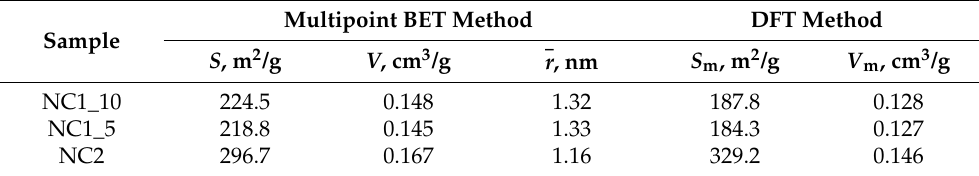
Table 5. Parameters of the porous structure of synthesized nanocomposites according to nitrogen adsorption/desorption